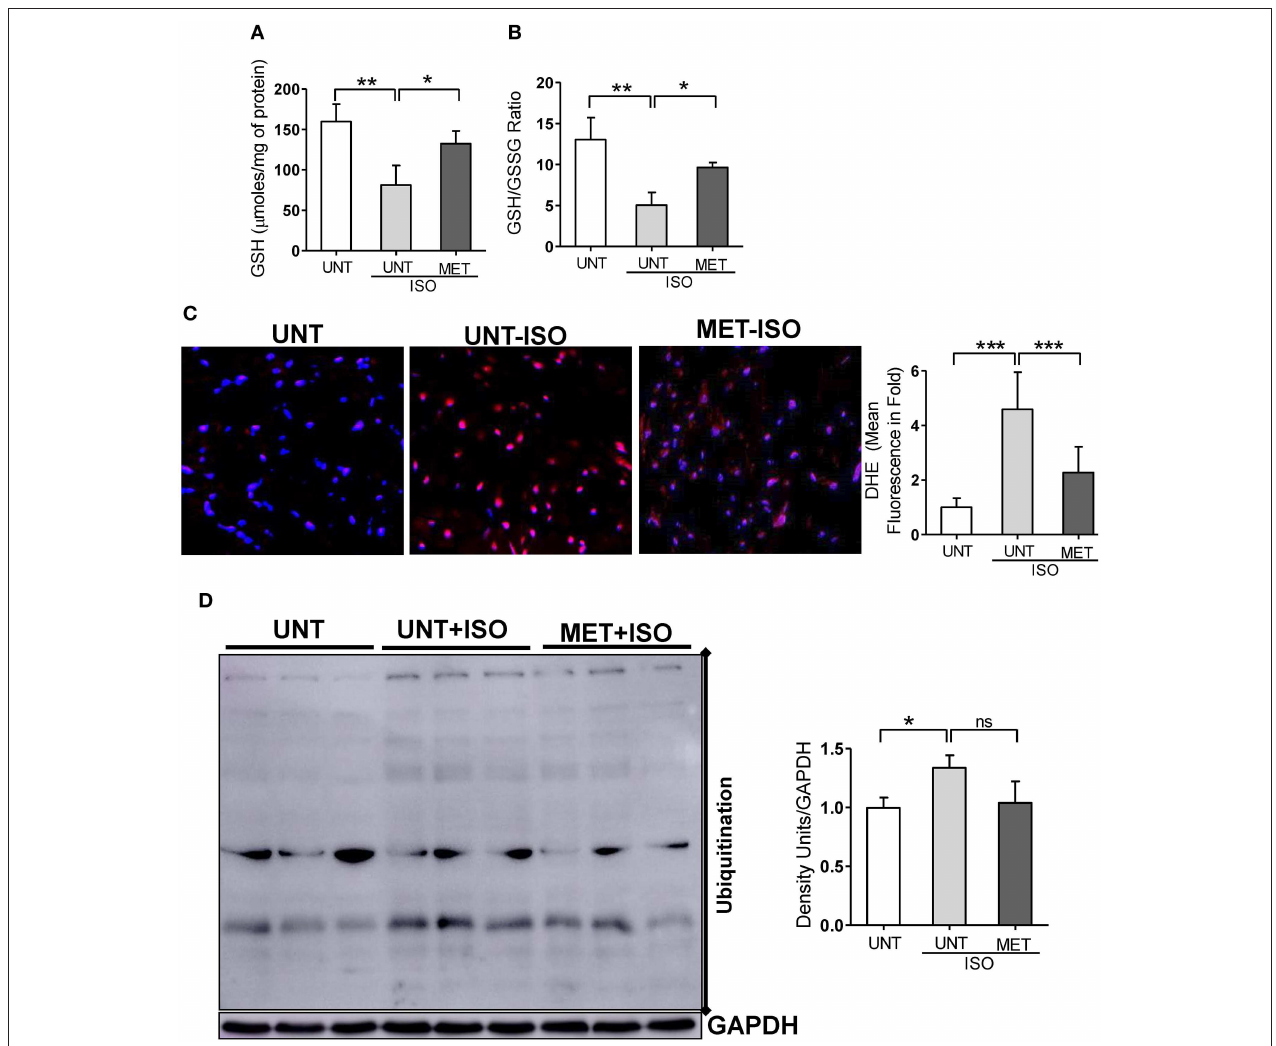
FIGURE 5 | Moderate intensity exercise training improved the glutathione redox levels, reduced the ROS and ubiquitination of proteins in Isoproterenol treated hearts. (A,B) Tissues from all three groups ( n = 4/group) were processed to prepare the MPA extracts and used for determining the myocardial glutathione (GSH) and oxidized glutathione levels (GSSG) by enzymatic recycling assay, (C) Hearts sections stained with specific fluorescence stain (DHE) for reactive oxygen species (ROS) and captured in Olympus light microscope at 40X magnification. ( n = 4/group). (D) Immunoblots for ubiquitination of proteins in the Isoproterenol induced cardiomyocytes. n = 3–4/group, values are represented as mean ± SD. Significance: * p < 0.05 ; ** p < 0.01 ; *** p < 0.001; ns, no